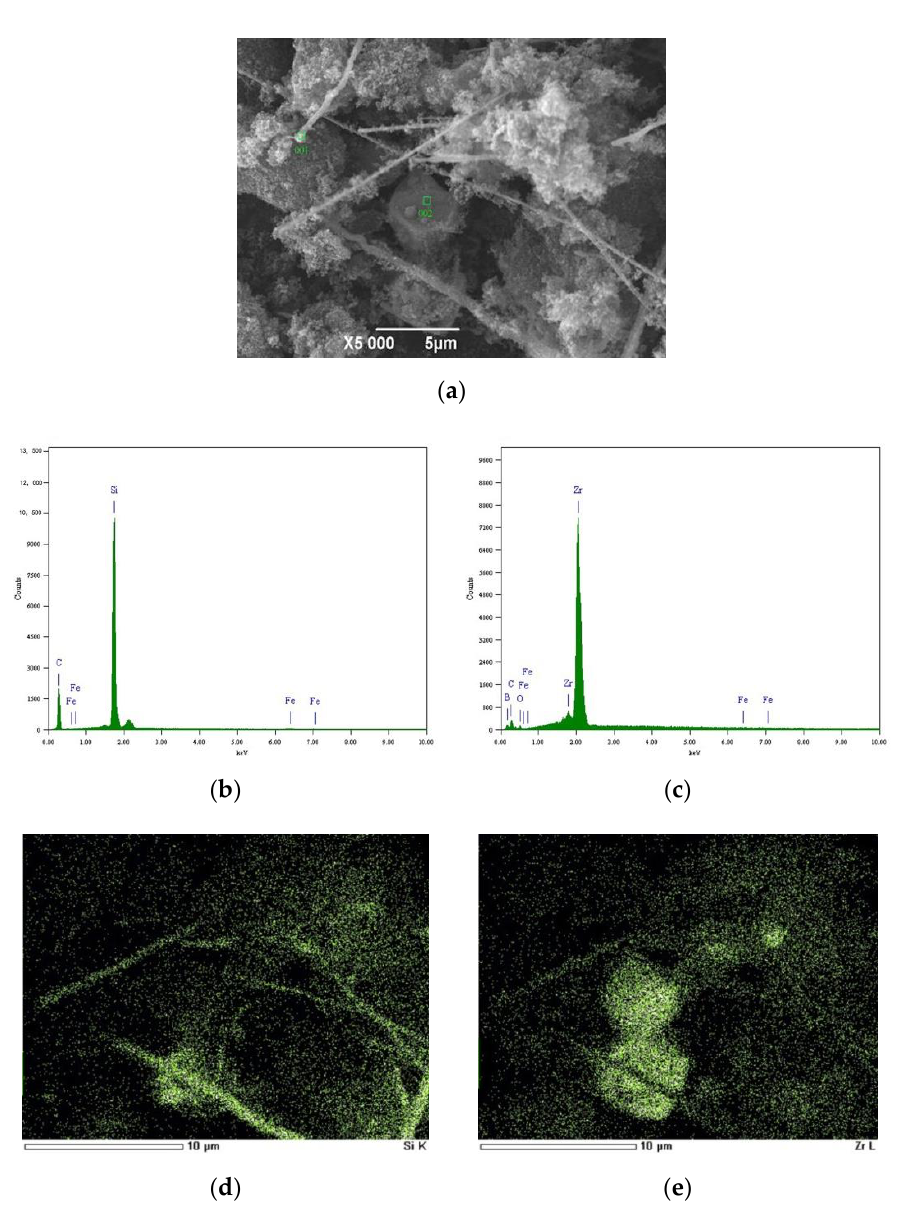
Figure 4. Microstructure of sample ZS2 heated at 1723 K for 3 h: ( a ) scanning electron microscopy (SEM) image; ( b ) energy-dispersive spectroscopy (EDS) spectra at point 001; ( c ) EDS spectra at point 002; ( d ) EDS mapping of Si element; ( e ) EDS mapping of Zr element.